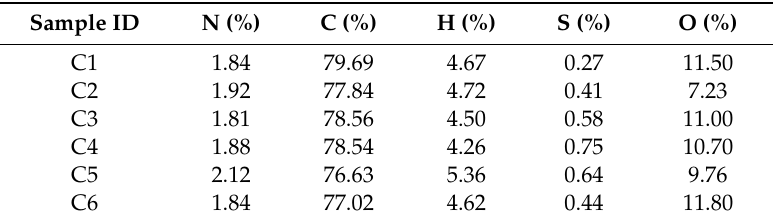
Table 1. Elemental composition of coal samples.